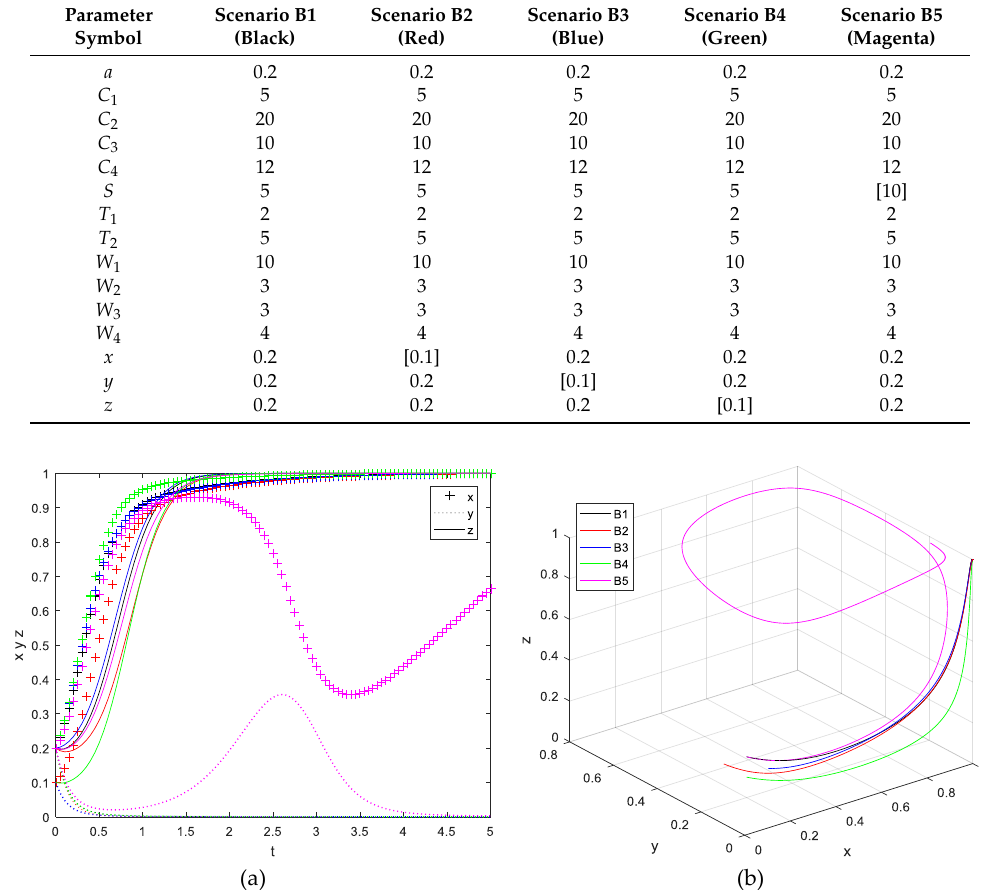
Table 5. Value of short supply scenario.